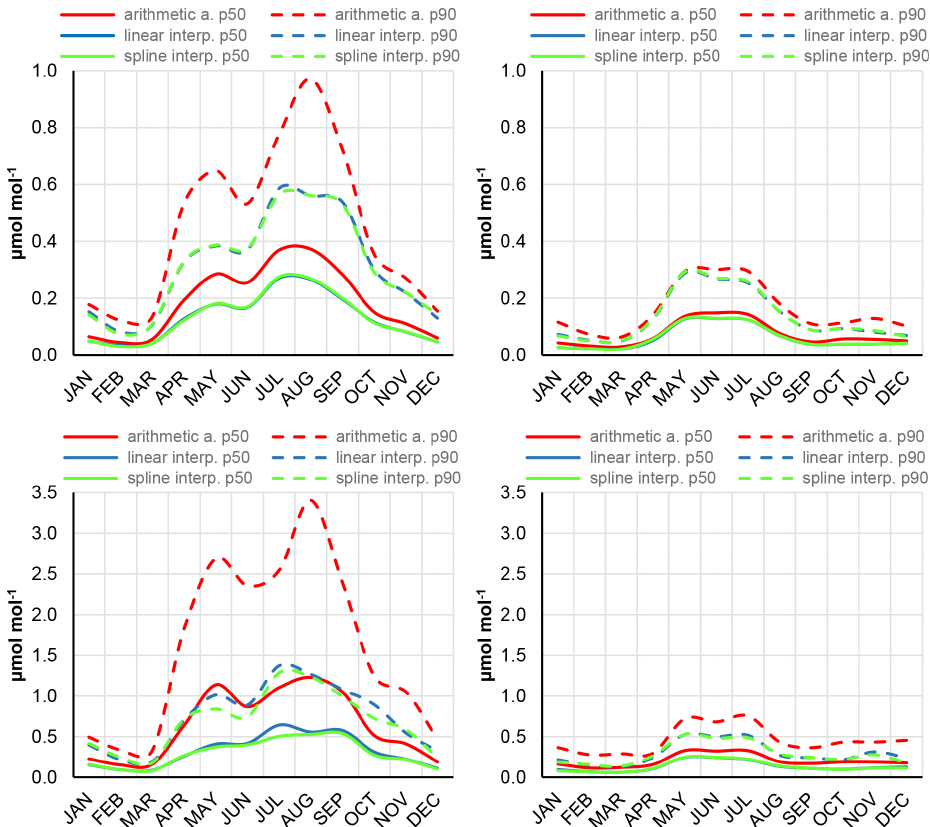
Figure 6. The seasonal variation of the median (p50) and the 90-percentile (p90) values of the absolute deviations of the hourly averages calculated using the different methods (arithmetic averaging, linear interpolation, spline interpolation of the available data) in the case of three intakes and for 120s (upper panels) and 600s (lower panels) sampling times. The left panels characterize the morning transition periods (06:00–08:00LST), while the right panels show the corresponding values for the early afternoon hours (13:00–15:00LST).